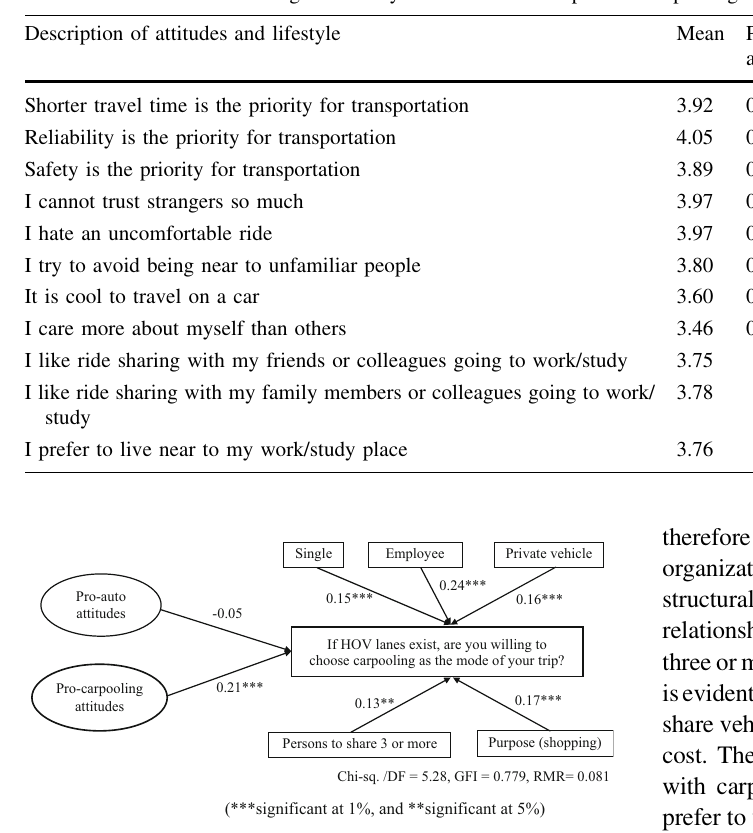
Fig. 2 Structural model of carpooling with lifestyles, attitudes and personal